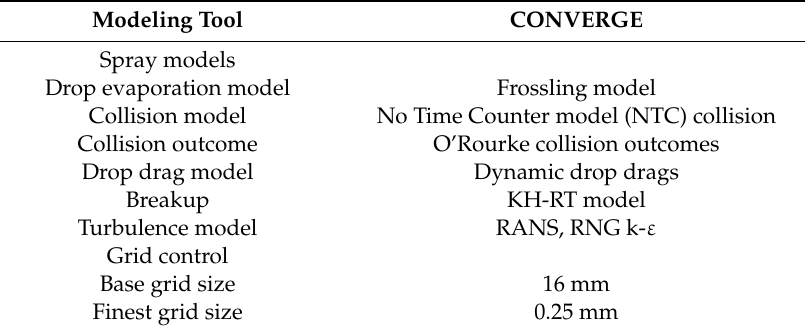
Table 1. Modeling and Numerical